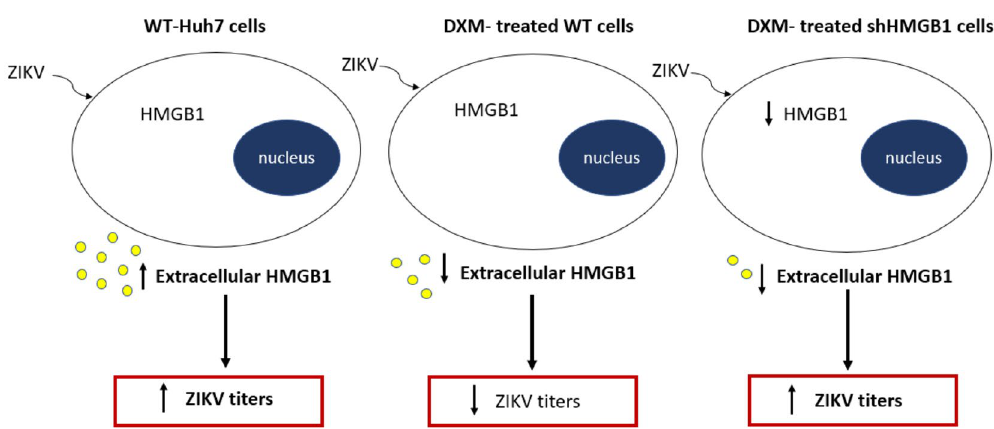
Figure 8. Model of HMGB1 and its role in ZIKV infection. ZIKV infection induces the translocation and release of HMGB1 in WT Huh7 cells. Treatment of dexamethasone in the ZIKV-infected WT cells inhibits the release of extracellular HMGB1 and ZIKV replication. However, the treatment in shHMGB1 cells does not cause the reduction of ZIKV titers, indicating the importance of the intracellular HMGB1 in ZIKV